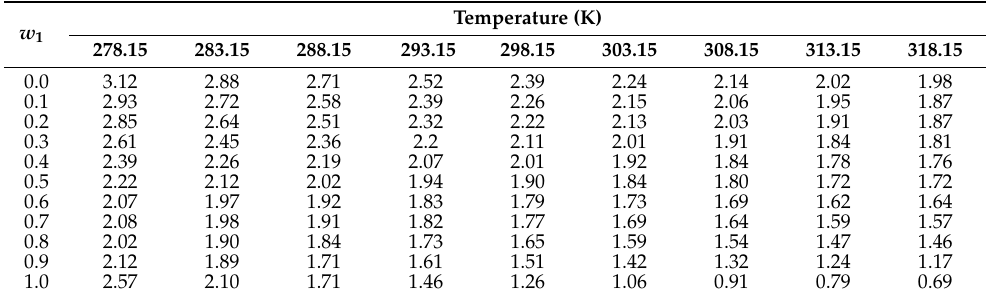
Table 4. Activity coefficient of isoniazid (3) in (PEG 200 (1) + water (2)) cosolvent mixtures at different temperatures and a pressure p = 0.096 MPa.